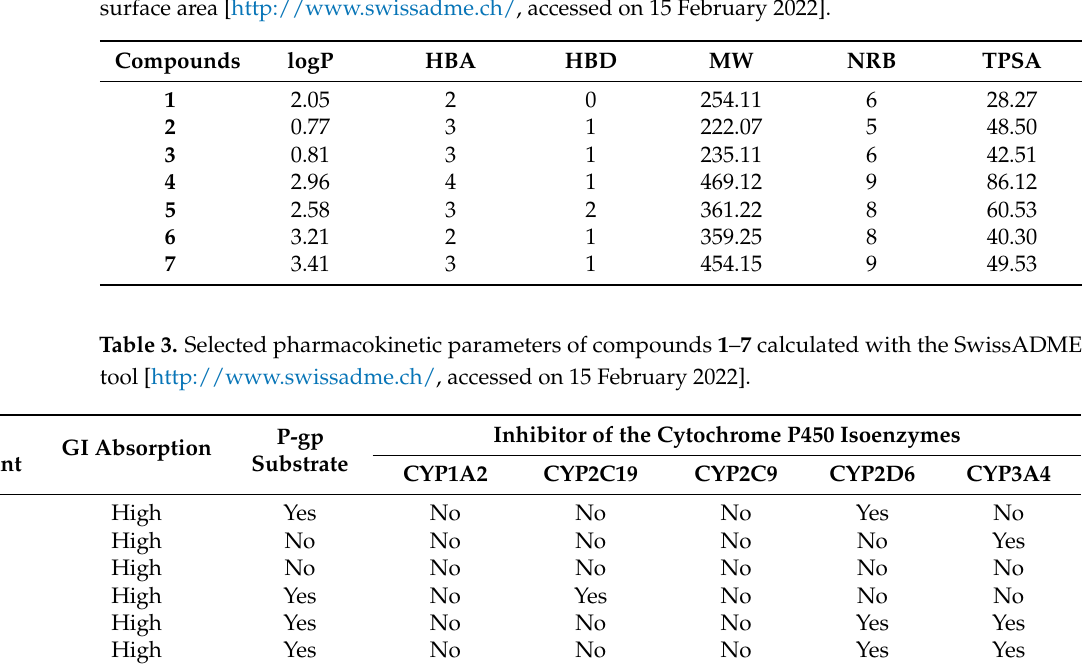
Table 2. Selected physicochemical parameters of compounds 1 – 7 calculated with the SwissADME tool. LogP—lipophilicity values; HBA—number of hydrogen bond acceptors; HBD—number of hy- drogen bond donors; MW—molecular weight; NRB—number of rotatable bonds; TPSA—topologi- cal polar surface area [http://www.swissadme.ch/, accessed on 15 February 2022].